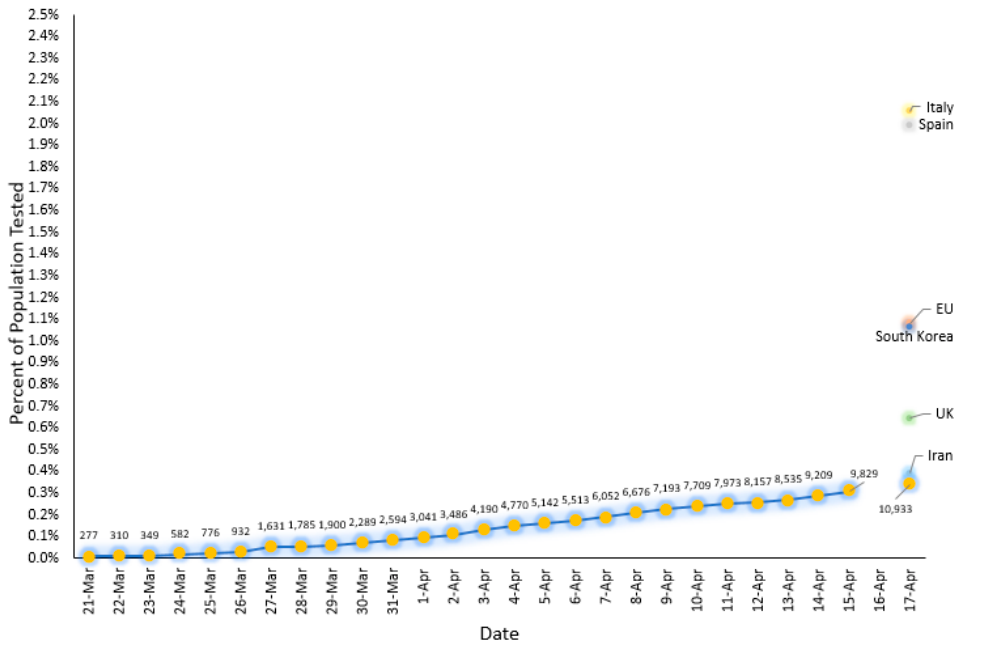
Figure 5. Diagnostic testing capacity as measured by percent of the population tested in Puerto Rico by sample collection date. Data points from other countries are included for reference (Source: data from the Puerto Rico Department of Health and The New York Times gathered and analyzed by Drs. Linnette Rodríguez and Héctor Colón).